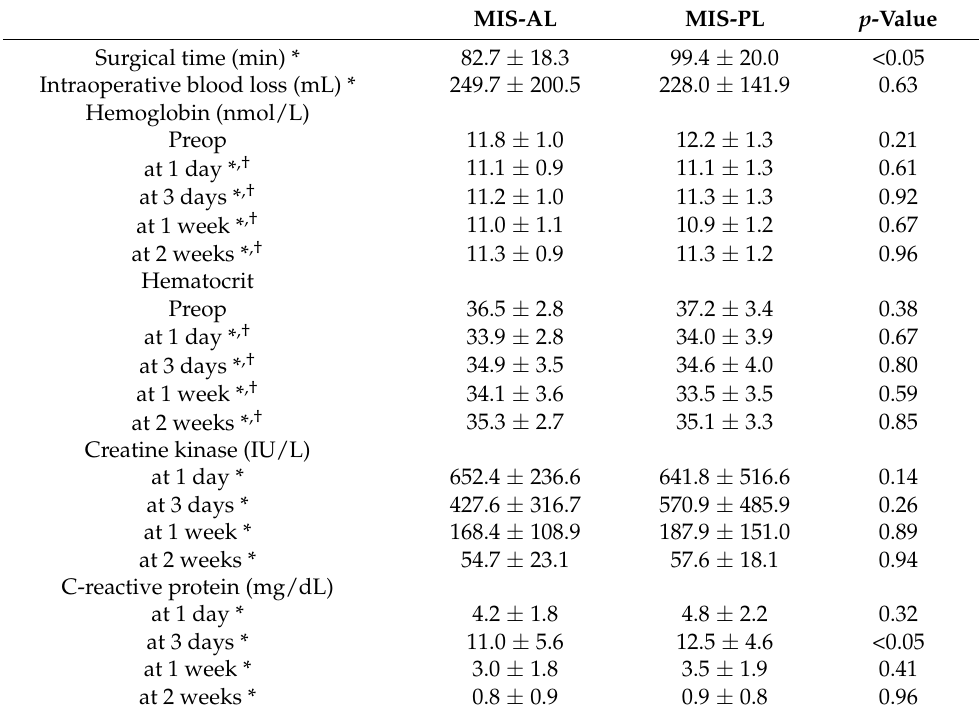
Table 2. Intraoperative data and postoperative hematological data.